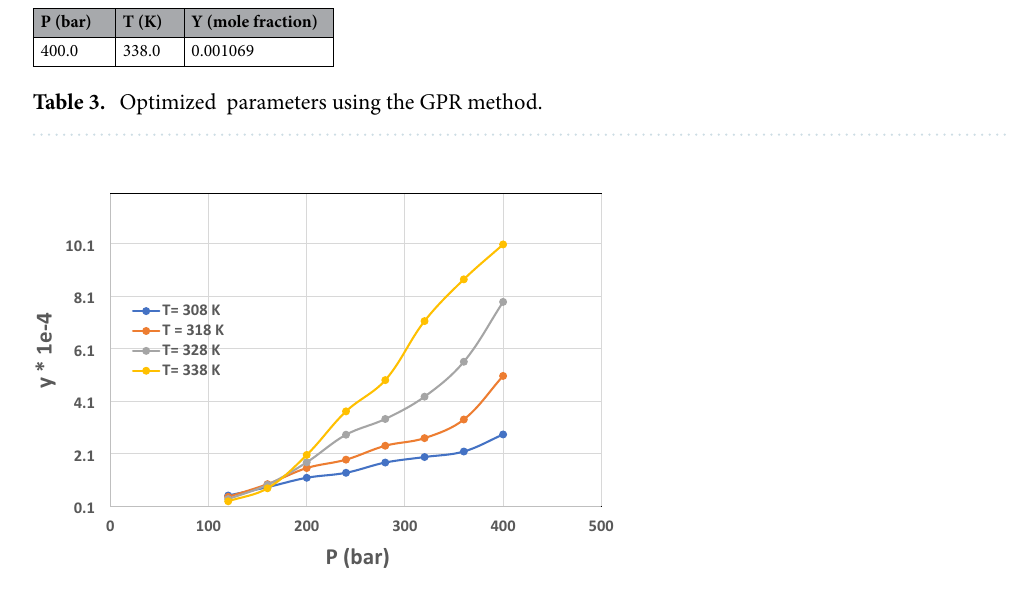
Figure 7. The impact of pressure on the solubility of Decitabine considering disparate